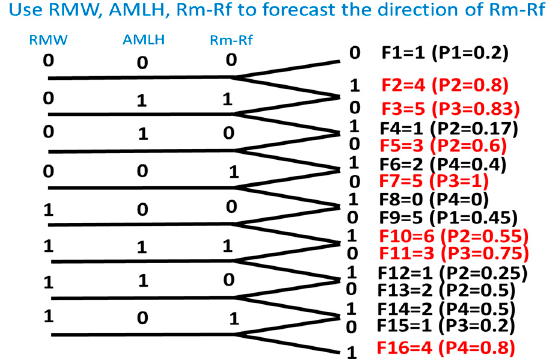
Figure A14. Use RMW and AMLH to forecast the direction of AMLH.